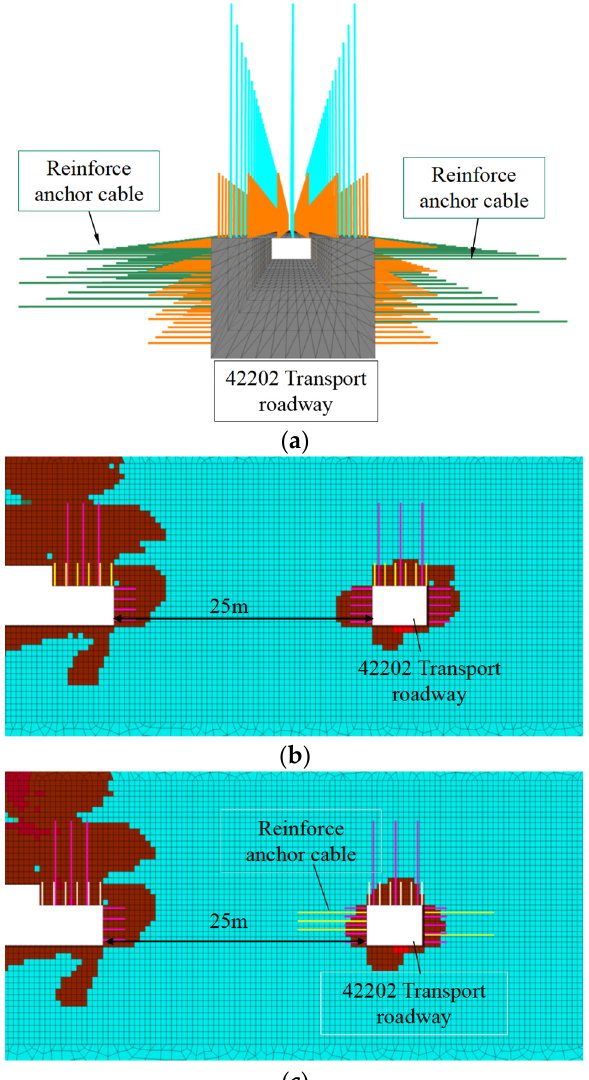
Figure 14. Numerical simulation verification of anchor cable reinforcement support effect. ( a ) Schematic Diagram of Anchor Cable Reinforcement and Support. ( b ) Distribution of plastic zone of surrounding rock before anchor cable reinforcement. ( c ) Distribution of plastic zone of surrounding rock after anchor cable reinforcement.